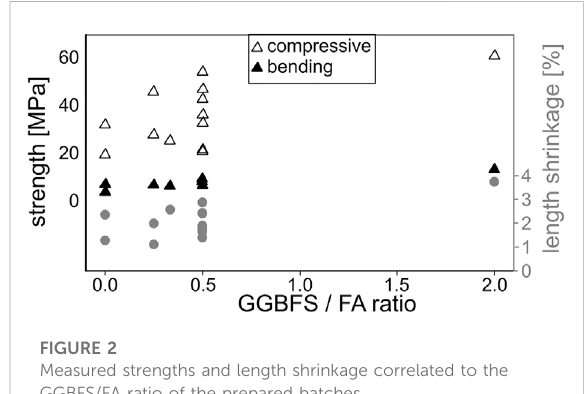
FIGURE 2 Measured strengths and length shrinkage correlated to the GGBFS/FA ratio of the prepared batches.